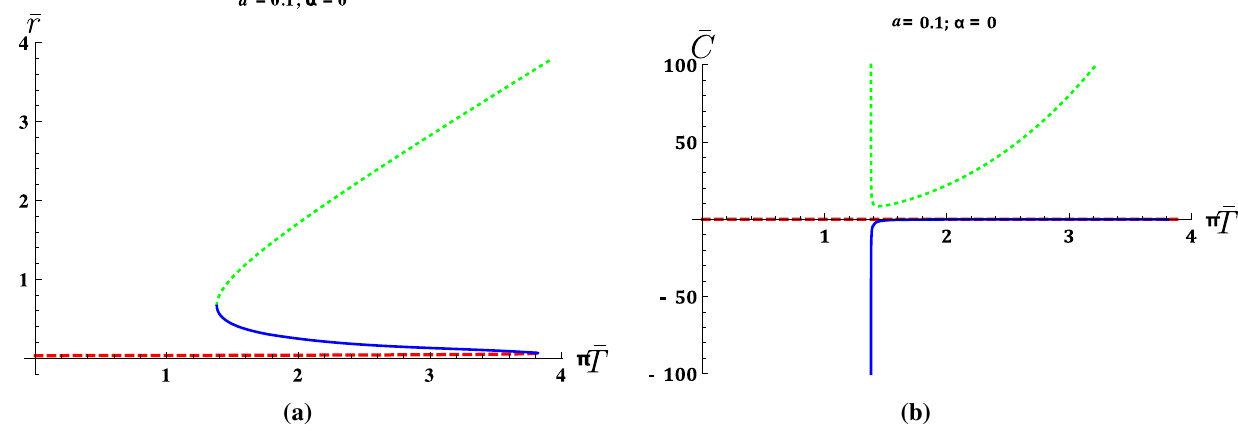
Fig. 4 a ¯ r vs π ¯ T plot b ¯ C vs. π ¯ T with ¯ α = 0, ¯ a = 0 . 1 for black holes with horizon radii small (red), medium (blue) and large(green)